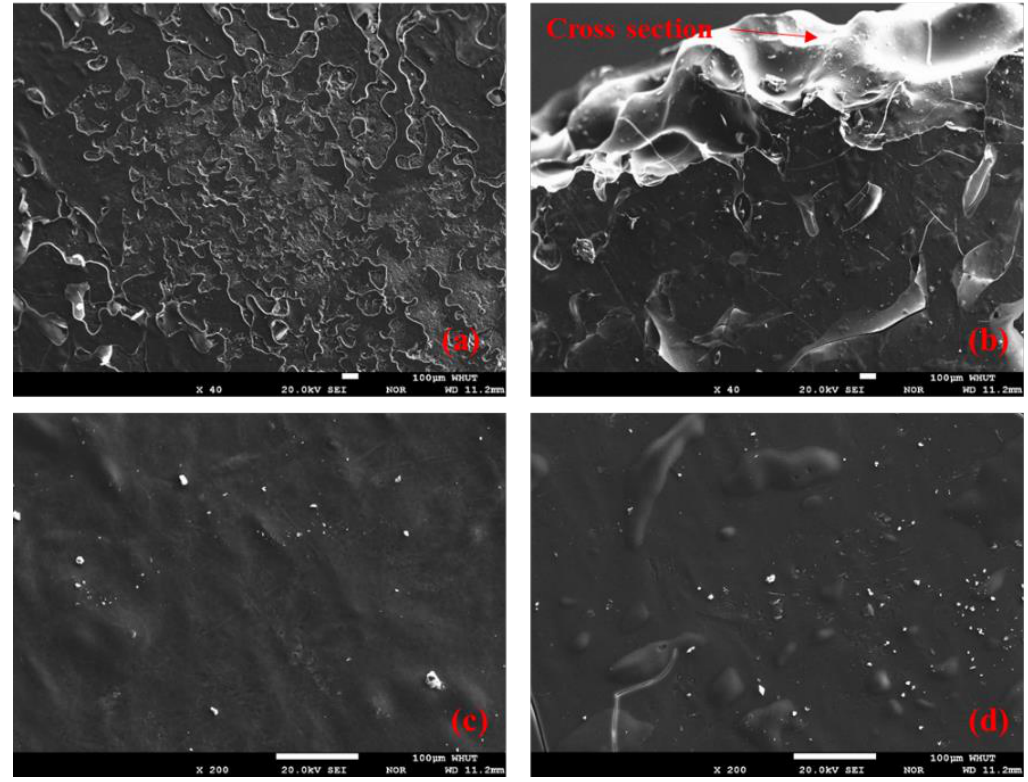
Figure 6. EPMA images of silicone resin: ( a ) surface of silicone at 40 magnification, ( b ) cross section at 40 magnification, ( c ) and ( d ) surface of silicone at 200 magnification.